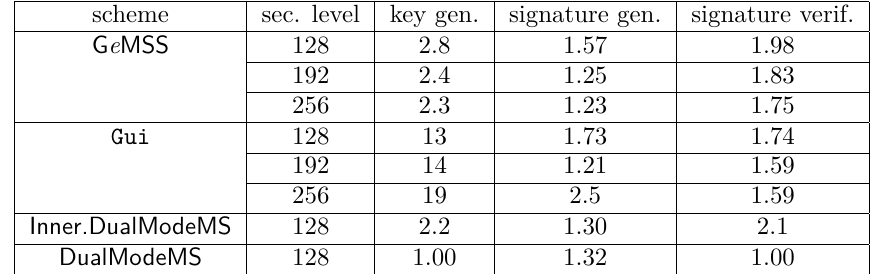
Table 1: Speed-up of G e MSS , Gui and DualModeMS (best implementation provided for the NIST submissions versus our implementation). We use a Haswell processor (ServerH).